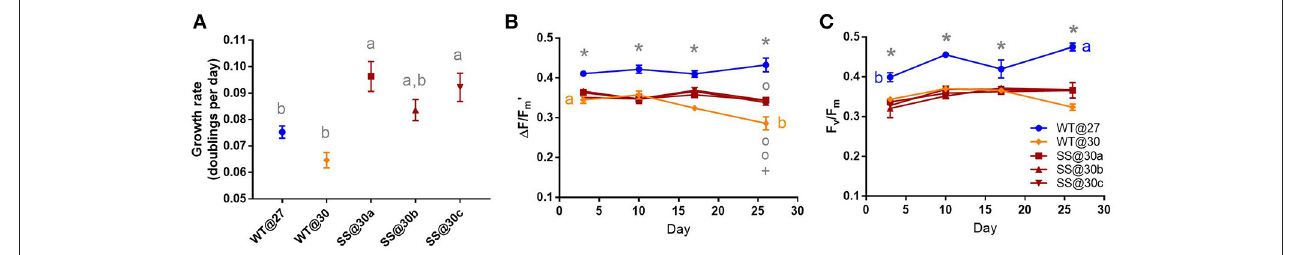
FIGURE 2 | Symbiodinium A3c. Results of transplant experiment; comparison of mean ( ± SEM) growth rates (A) , effective quantum yields (B) and maximum quantum yields (C) between the wild-type (WT) Symbiodinium type A3c population at 27 ◦ C (WT@27), WT transferred into 30 ◦ C (WT@30) and the three selected Symbiodinium A3c populations (SS@30a, b, c). Populations’ were pre-acclimated for 14 days and growth rates were measured following 17 more days and quantum yield measurements over the following 26 days. Statistically significant differences among populations at a given time point are represented by different letters (A) or symbols above/below the mean points (B,C) . Statistically significant differences over time (between D3 and D26) are represented by different letters ( B,C , Tukey’s post-hoc tests; P < 0.05), n = 3 for all means. Where error bars are not visible, they are small and hidden by the symbols.